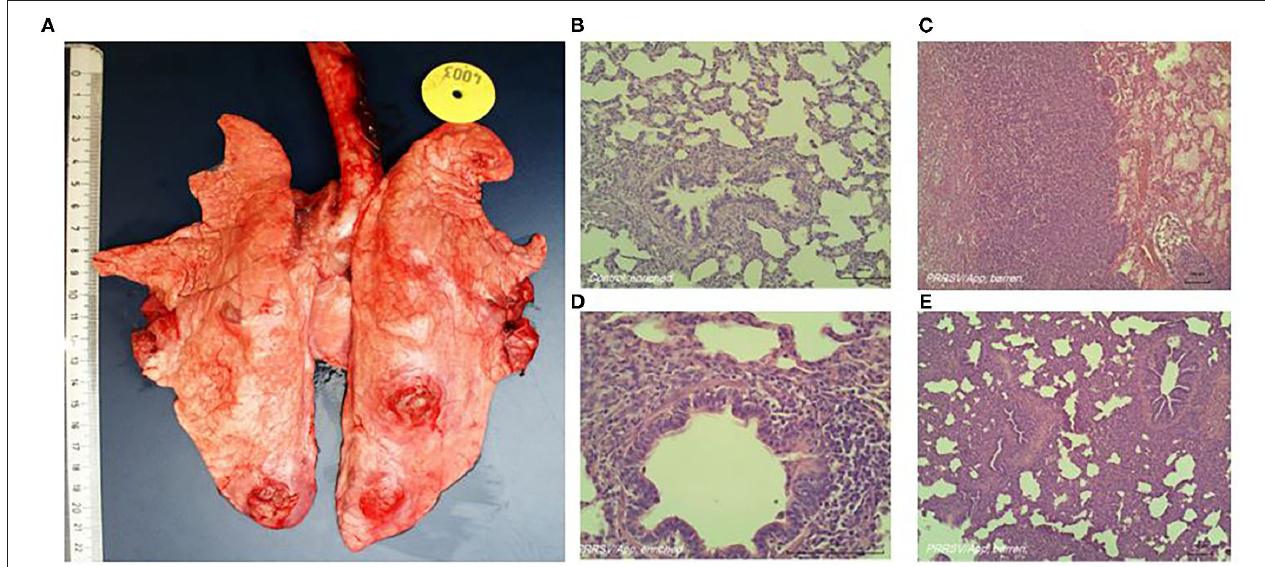
FIGURE 1 | Representative macroscopic (A) and histologic (B–E) lung lesions caused by coinfection of porcine reproductive and respiratory syndrome virus (PRRSV) and Actinobacillus pleuropneumoniae . (B) Absence of histological alterations; healthy lungs in non-infected animals. (C) Diffuse severe alterations (interstitial or catarrhal pneumonia, infiltrations in alveolar septa and peribronchial or perivascular area, pleuritis). (D) Close-up of (mild) infiltrations of perivascular and peribronchial area. (E) Diffuse severe alterations (interstitial or catarrhal pneumonia, infiltrations in alveolar septa and peribronchial or perivascular area, pleuritis).